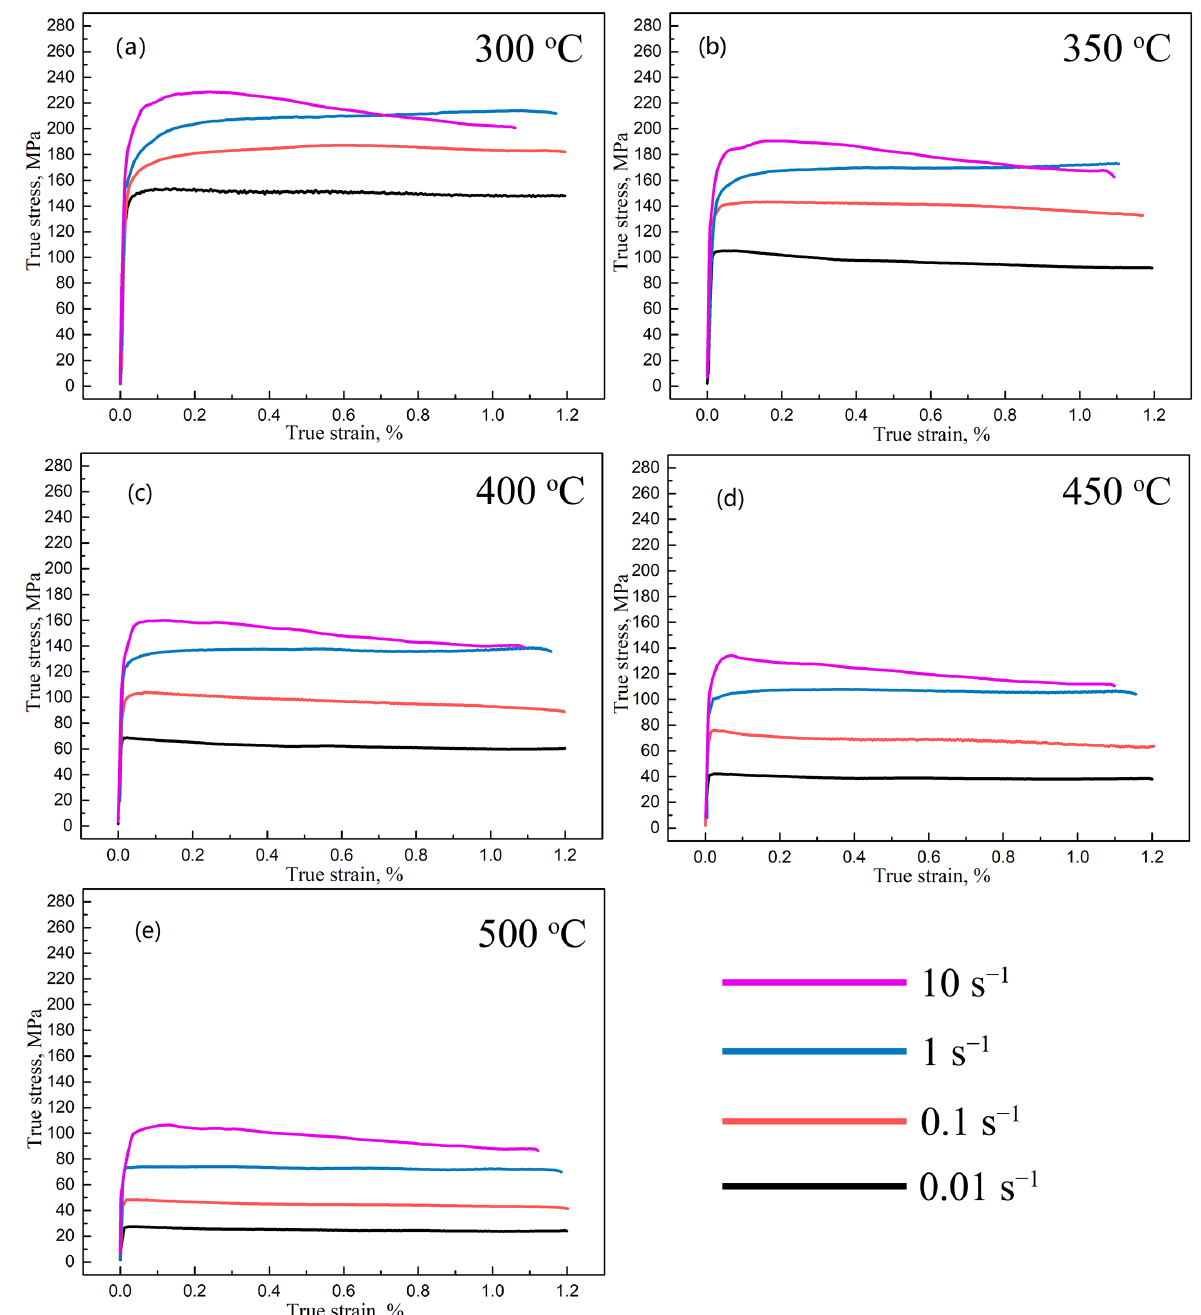
Figure 4. Hot compression true stress − strain curves of C alloy (5182 − 0.1Sc − 0.1Zr alloy) at ( a ) 300 °C, ( b ) 350 °C, ( c ) 400 °C, ( d ) 450 °C, and ( e ) 500 °C.